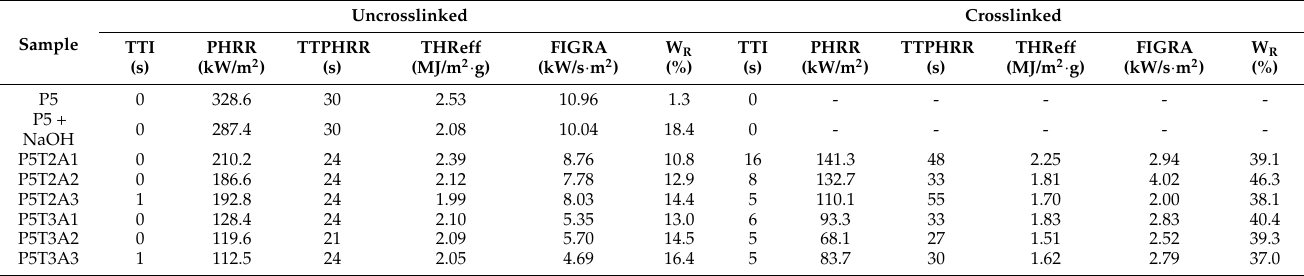
Table 5. Cone calorimeter parameters for the different aerogels under study. Crosslinked samples were tested in a dry state. Uncrosslinked samples were tested after stabilization at 25 ◦ C and 50% RH.